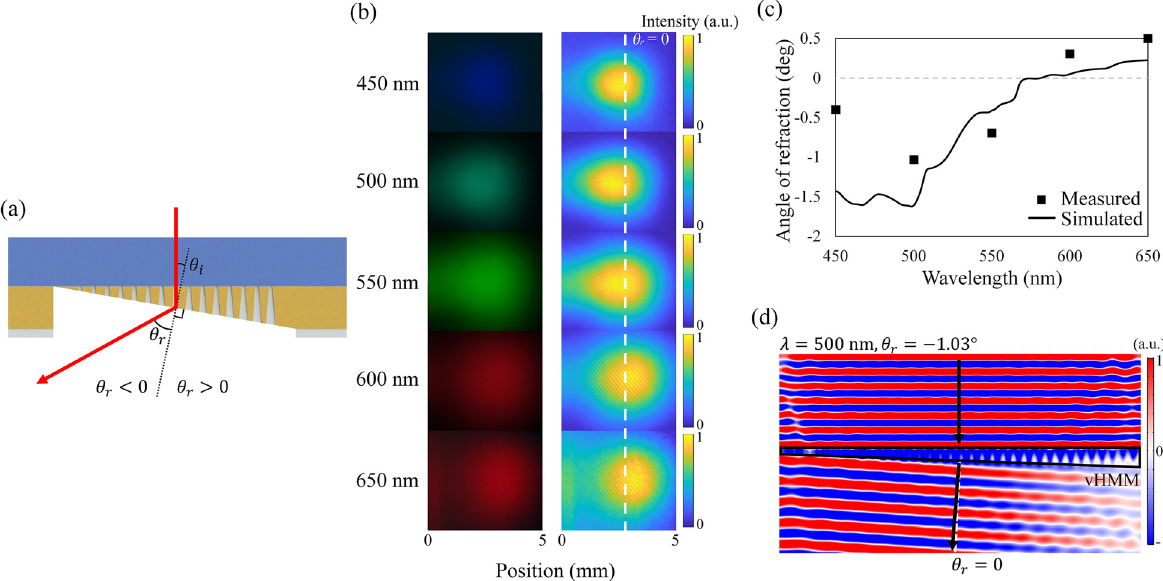
Figure 4: Observation of negative refraction. (a)SchematicofnegativerefractioninavHMM.Ifnegativerefractionoccurs,thetransmittedlightpropagatestowardtheleftofthedashedline andtheangleofrefraction θ r becomesnegative.(b)Capturedimages(left)andtheintensitypro fi les(right).Theimagesarecapturedattheleft side of the dashed line where negative refraction occurs. (c) Simulated and measured angles of refraction of the vHMM. Error bars are smaller than the point markers. (d) Simulated electric fi eld pro fi le at λ = 500 nm. The simulated θ r = − 1.03 ° .